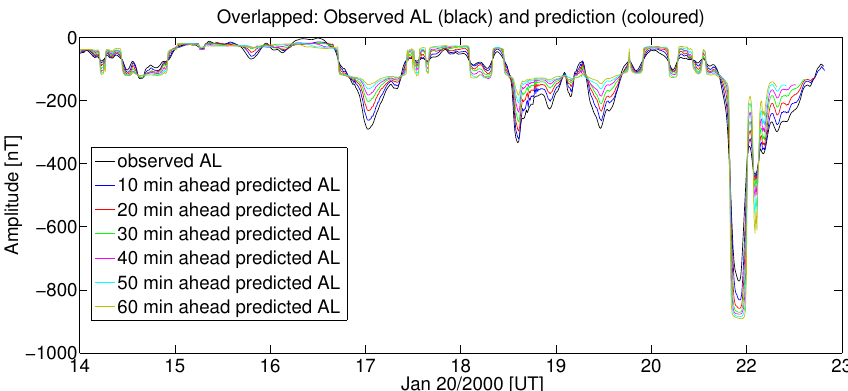
Fig. 4. Model performance at various prediction steps, ranging from 10 to 60min ahed. The figure depicts an event that took place on 20 January 2000.